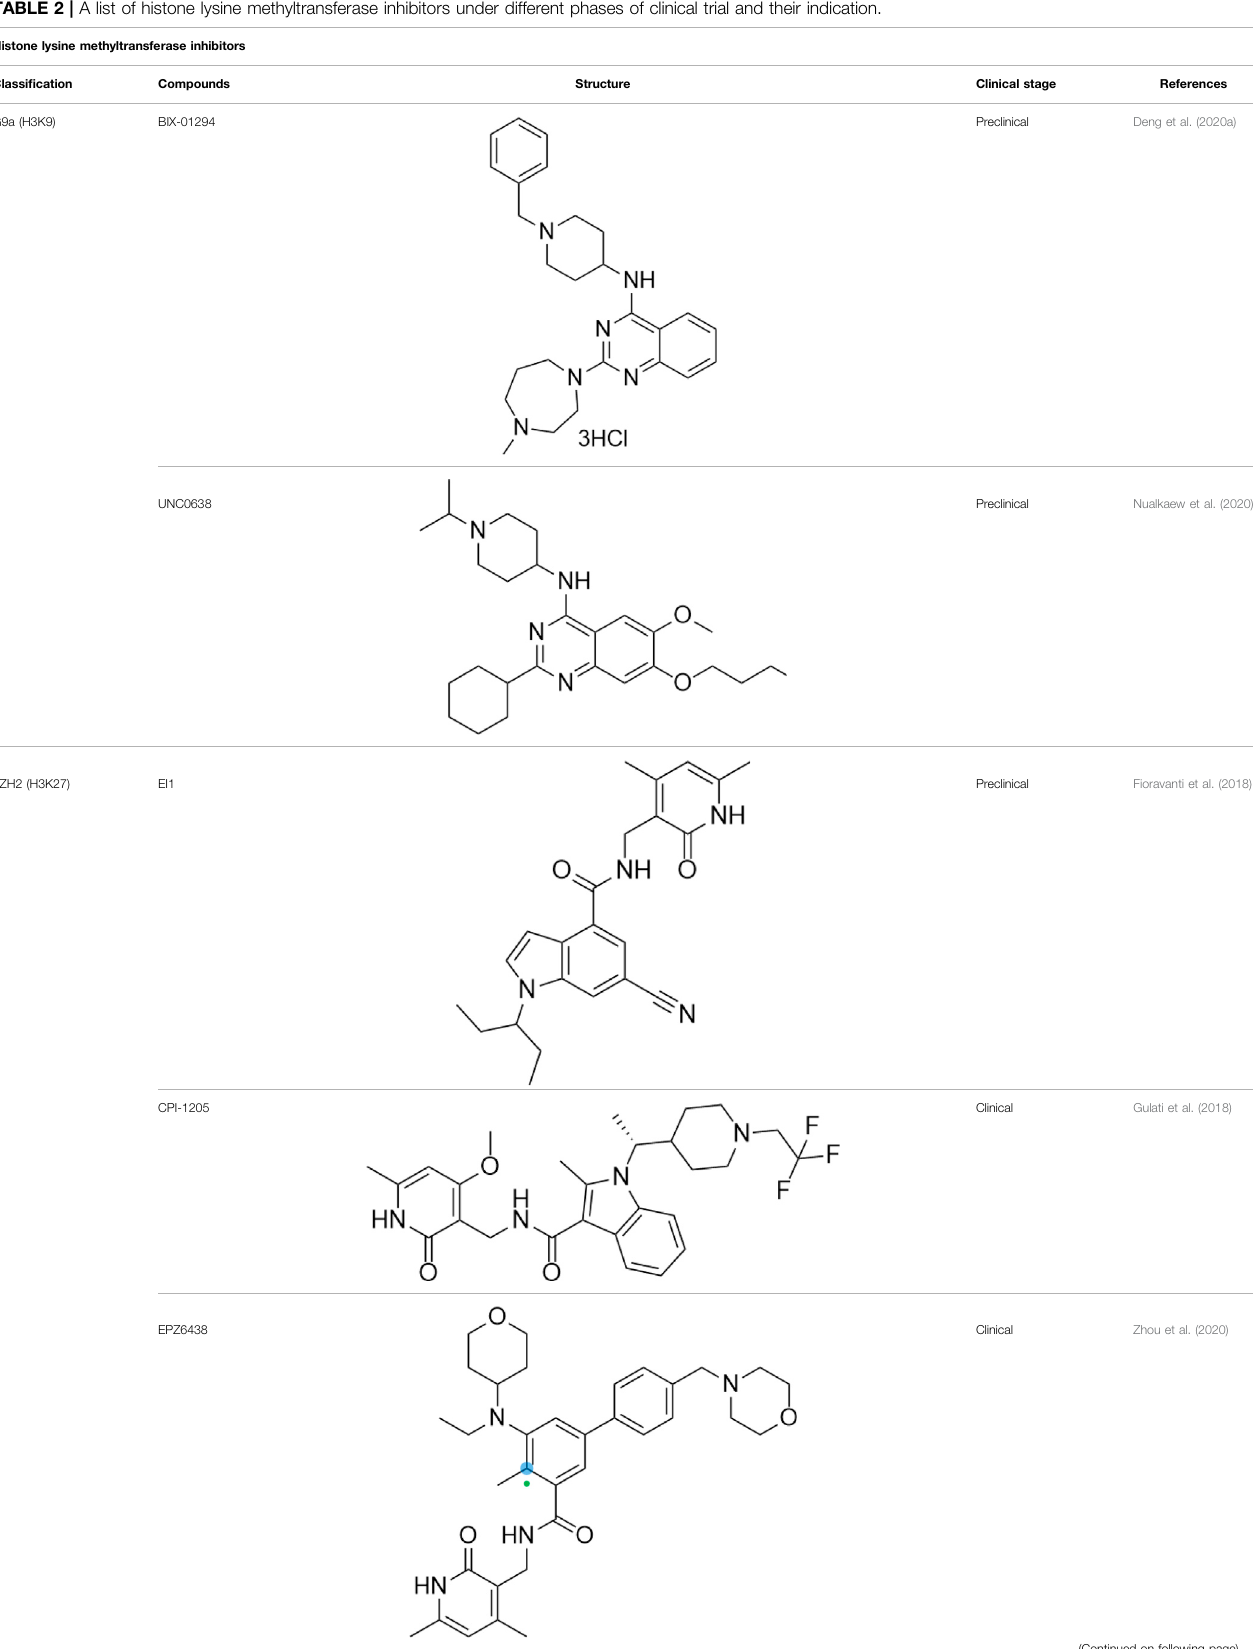
TABLE 2 | A list of histone lysine methyltransferase inhibitors under different phases of clinical trial and their